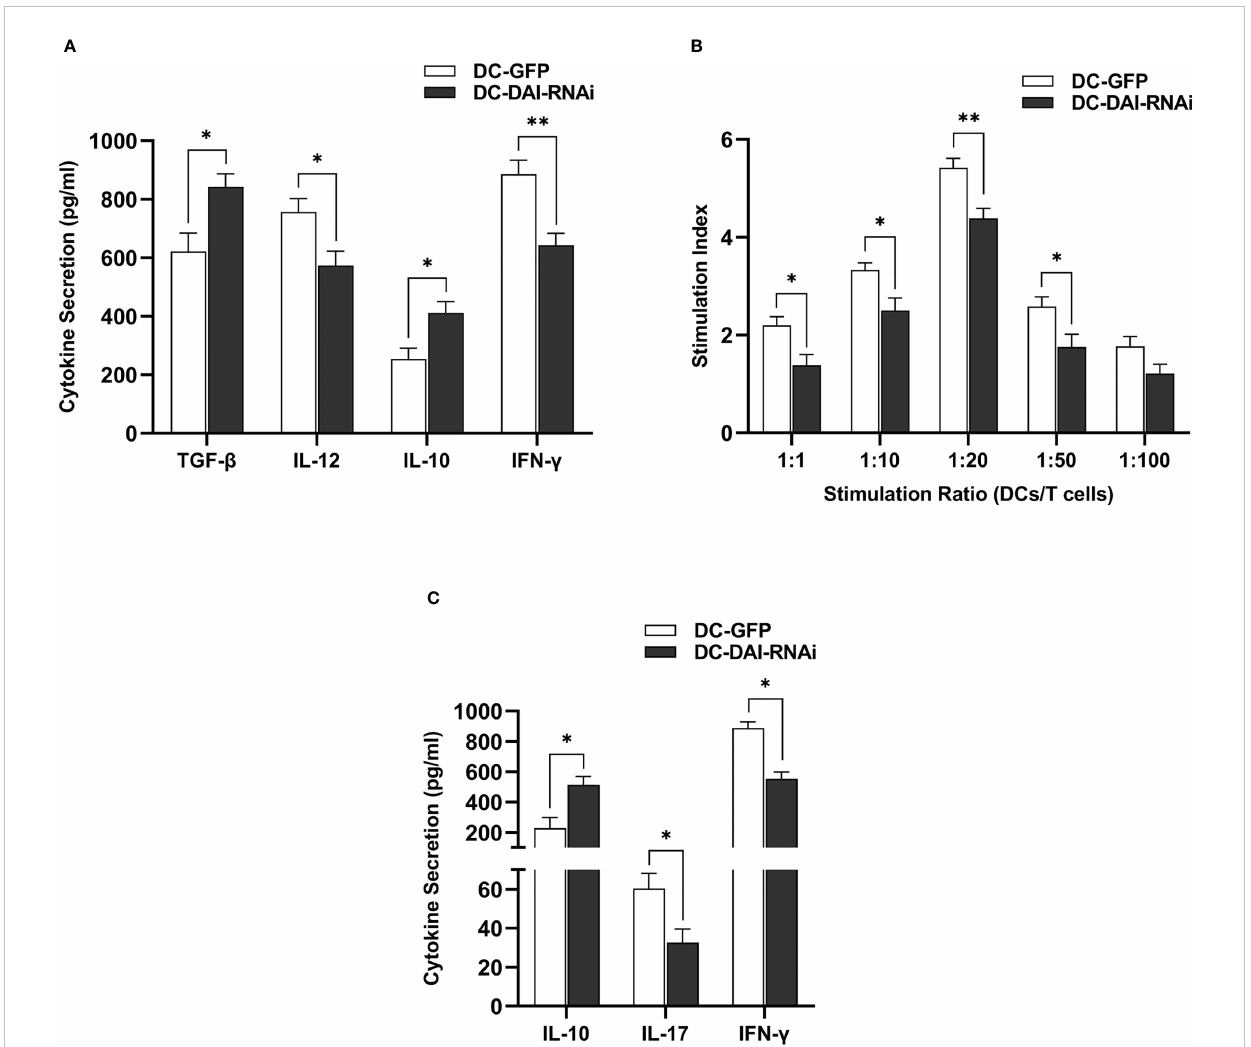
FIGURE 3 DC-DAI-RNAi exhibited the immunosuppressive properties of tolerogenic DCs (tolDCs). (A) DC-DAI-RNAi secreted higher levels of immunosuppressive cytokines and lower levels of immunostimulating cytokines than DC-GFP (*P < 0.05, **P < 0.01, n=5). (B) The capacities of DCs to stimulate T cell proliferation in different ratios were evaluated by stimulation index (SI), which was calculated according to the following formula: stimulation index = (OD sample − OD blank control )/(OD negative control − OD blank control ) (*P < 0.05, **P < 0.01, n=5). (C) DC-DAI-RNAi increased IL-10 level and reduced IL-17 and IFN- g levels in the supernatant of the mixed lymphocyte reaction (MLR) (*P < 0.05,